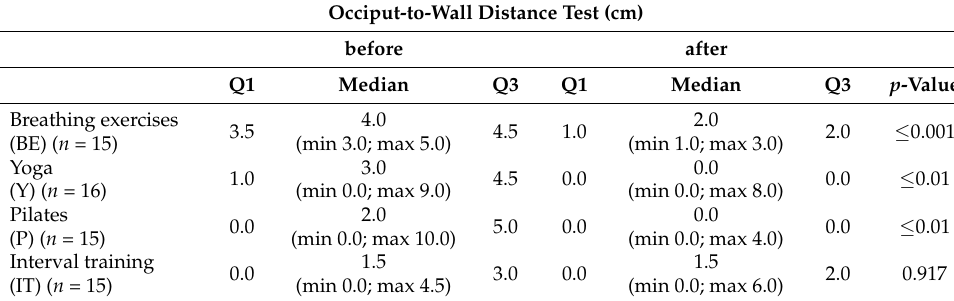
Table 4. Results of the occiput-to-wall distance (OWD) test (cm) of the four groups (target BE programme and three other programmes: yoga, Pilates and dynamic interval training) before and